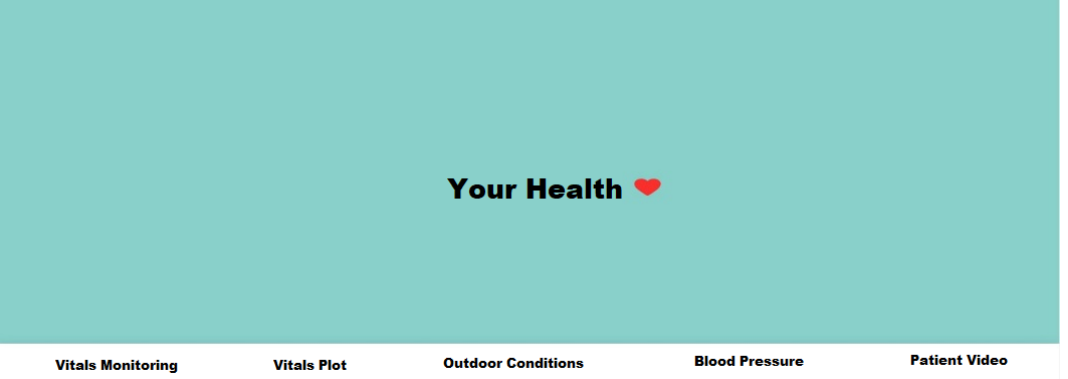
Figure 6. User interface of the “Your Health” webpage.